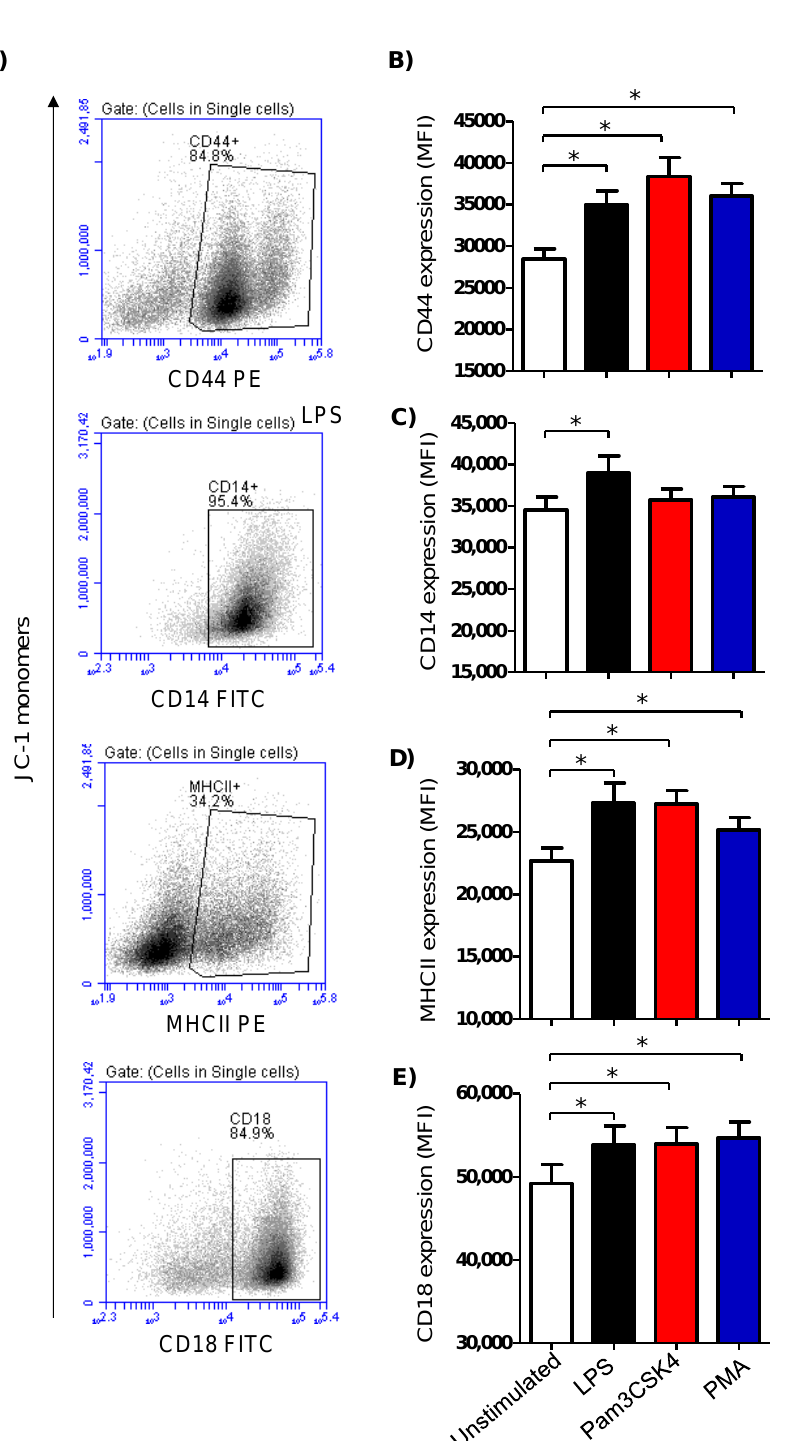
Figure 3. Analysis of the expression of the cell marker antigens CD44, CD14, MHCII, and CD18 on milk cells. Cells were separated from stimulated and non-stimulated milk samples, stained with monoclonal antibodies, and analyzed using flow cytometry. ( A ) Representative density plots (SSC-H against specific staining with the corresponding antibody) showing the expression density of the cell surface antigens after setting a gate on single cells. ( B ) Mean fluorescence intensity (MFI) of CD44 ( B ), CD14 ( C ), MHCII ( D ), and CD18 ( E ) on milk cells ( n = 7 camels). * indicates statistically significant differences between the groups ( n = 7 camels; p values less than 0.05).